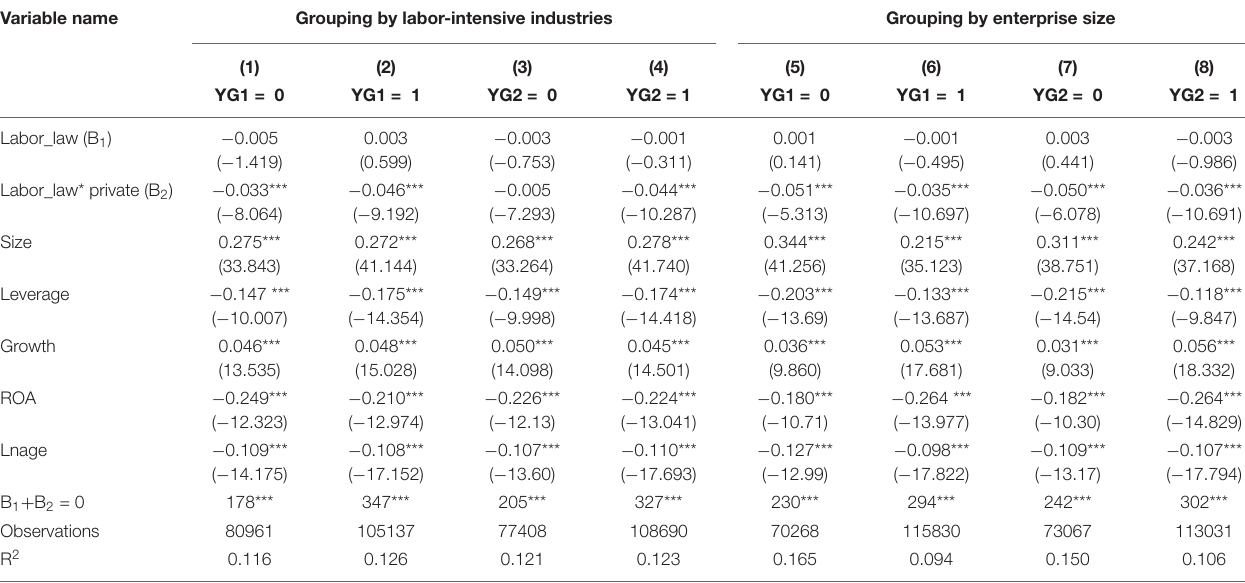
TABLE 4 | The LPL, property right nature and Enterprise investment − grouping test based on employee and size of industrial